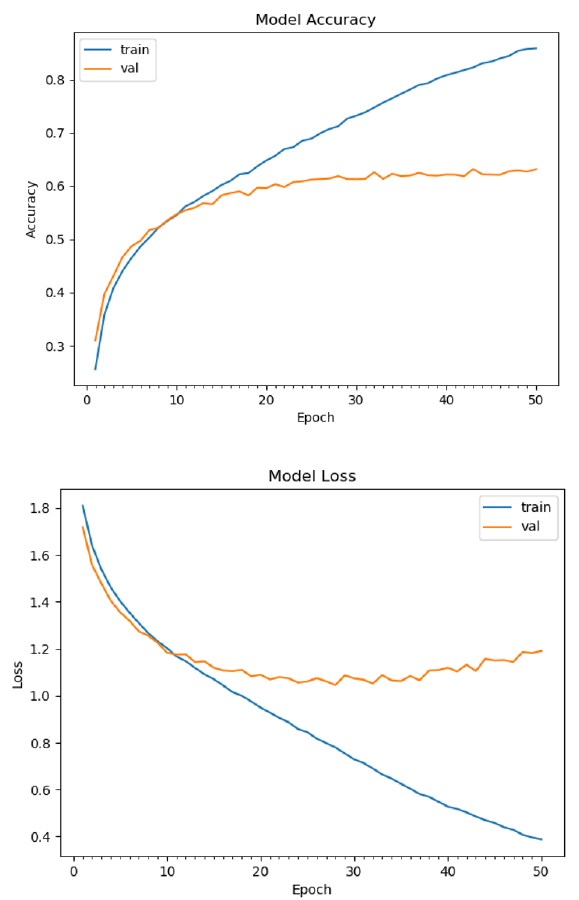
Fig. 3. Accuracy and loss curve after